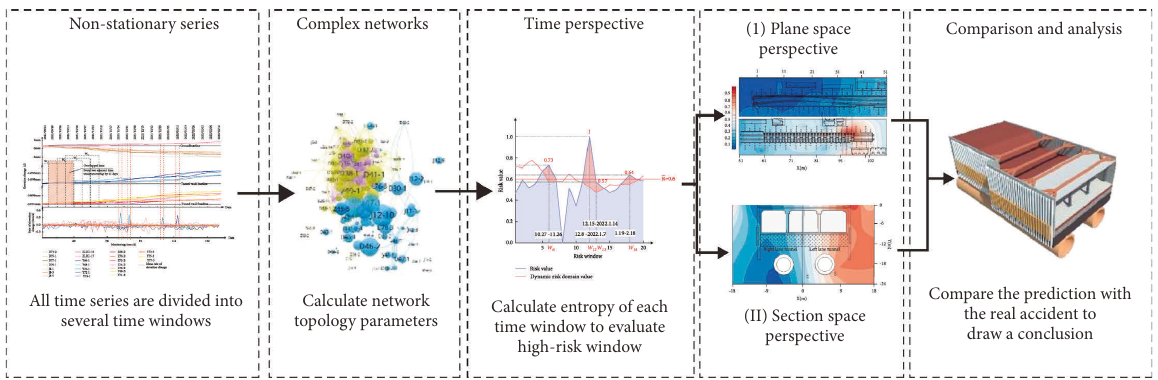
Figure 1: Flow chart for quantifying the risk evolution of deep foundation pits adjacent to existing